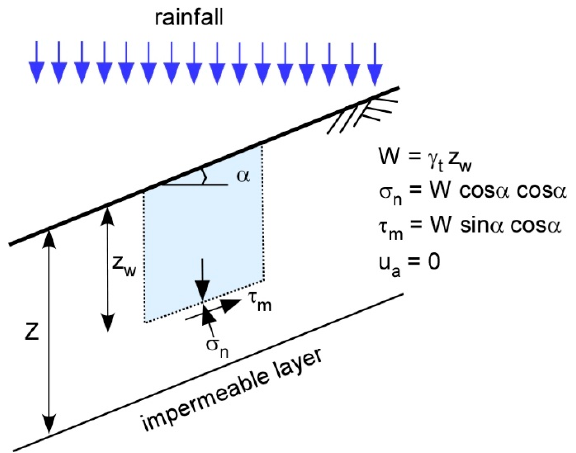
Figure 5. Diagram of infinite slope stability analysis applying a unified effective stress model [22].